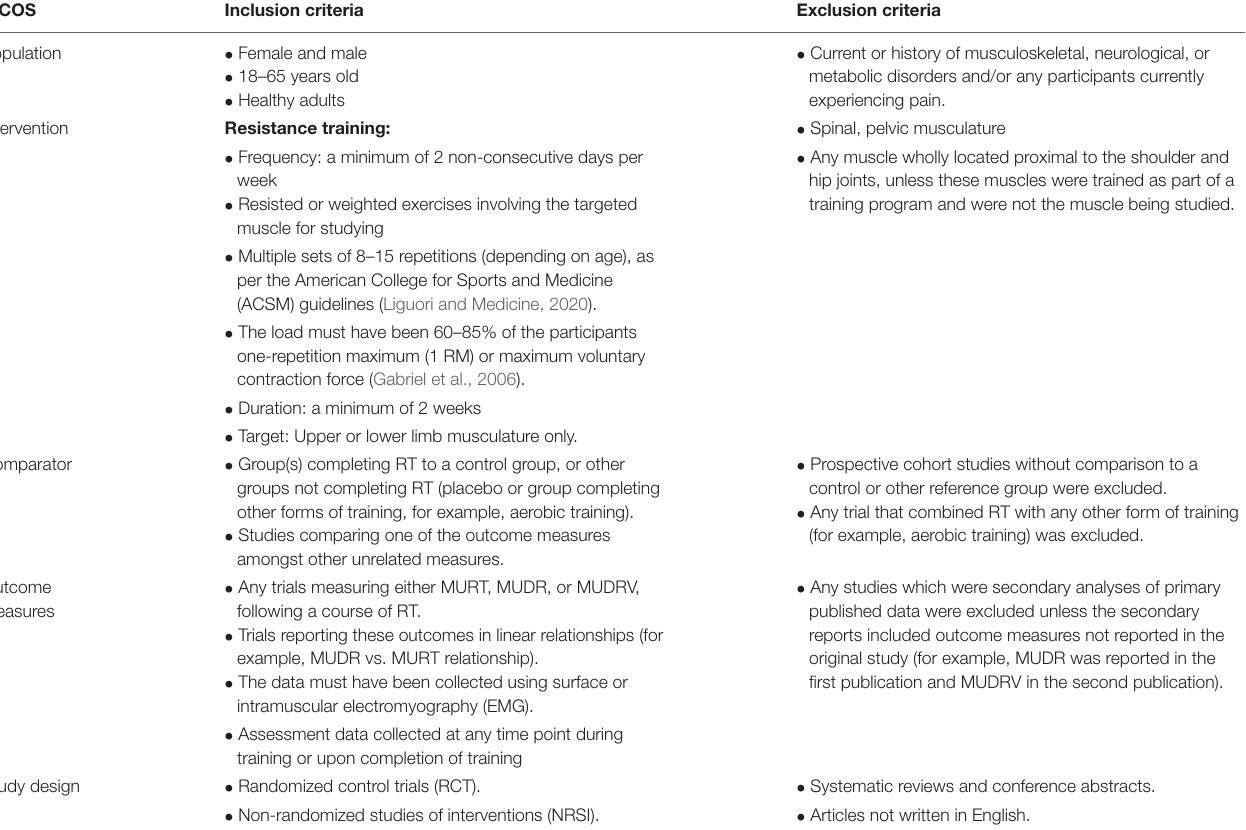
TABLE 1 | Eligibility